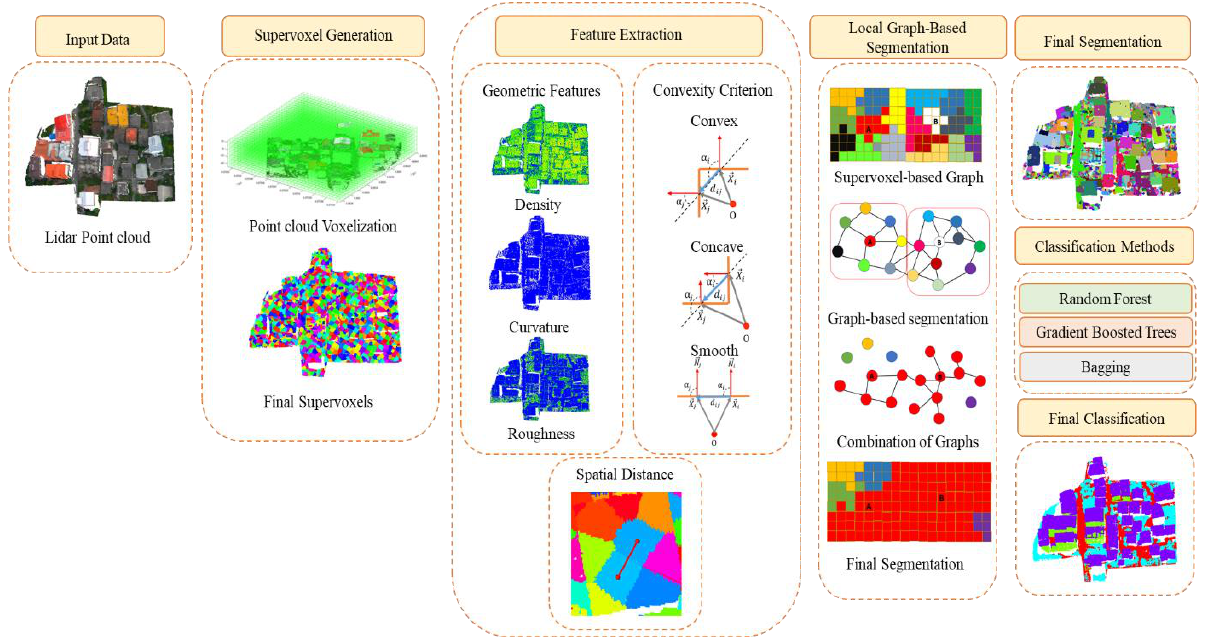
Figure 1 . The general framework of the proposed method.